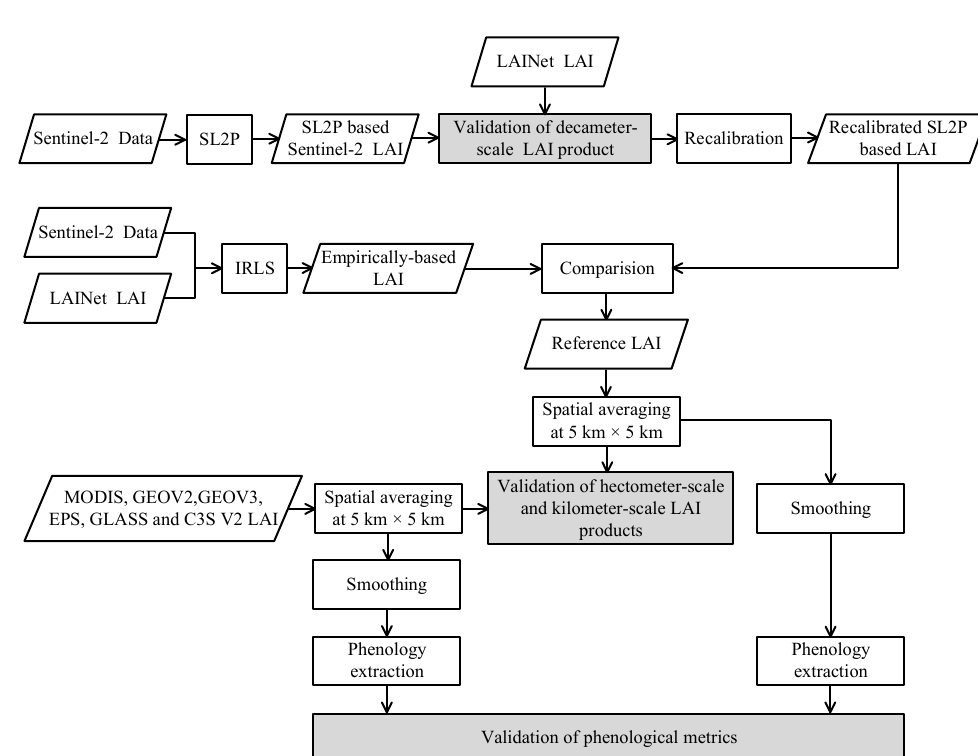
Figure 2. Flowchart of the multi-resolution LAI products validation. First, the SL2P-based Sentinel-2 LAI product was validated and recalibrated with ground measurements from LAINet. The recalibrated SL2P LAI was compared with an empirically based LAI resulting from up-scaling LAINet measurements with Sentinel-2 reflectance data thought the iteratively re-weighted least squares algorithm (IRLS). This resulted in reference maps. Second, hectometric and kilometric LAI products were validated by comparison with the reference maps. Third, phenological metrics from hectometric/kilometric and reference LAI time series were extracted and compared.